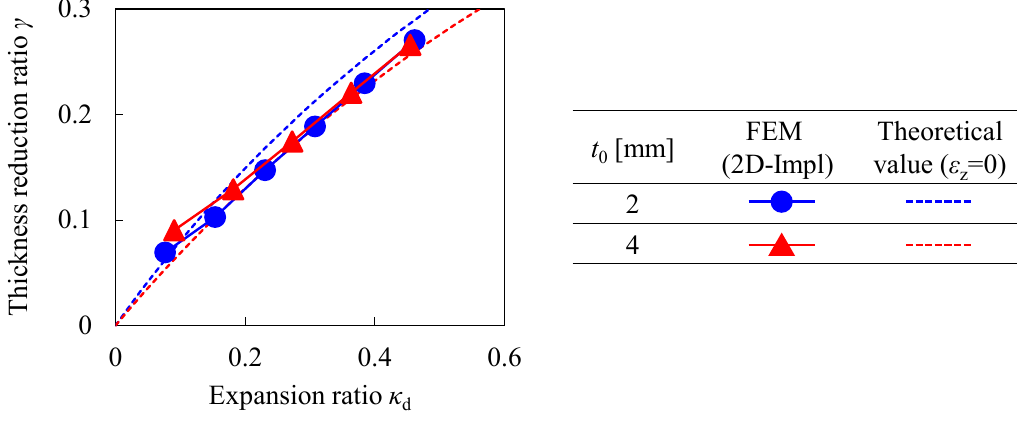
Figure 10. Effect of expansion ratio κ d on thickness reduction ratio γ (STKM13C, 2D FEM). Figure 10. E ff ect of expansion ratio κ d on thickness reduction ratio γ (STKM13C, 2D